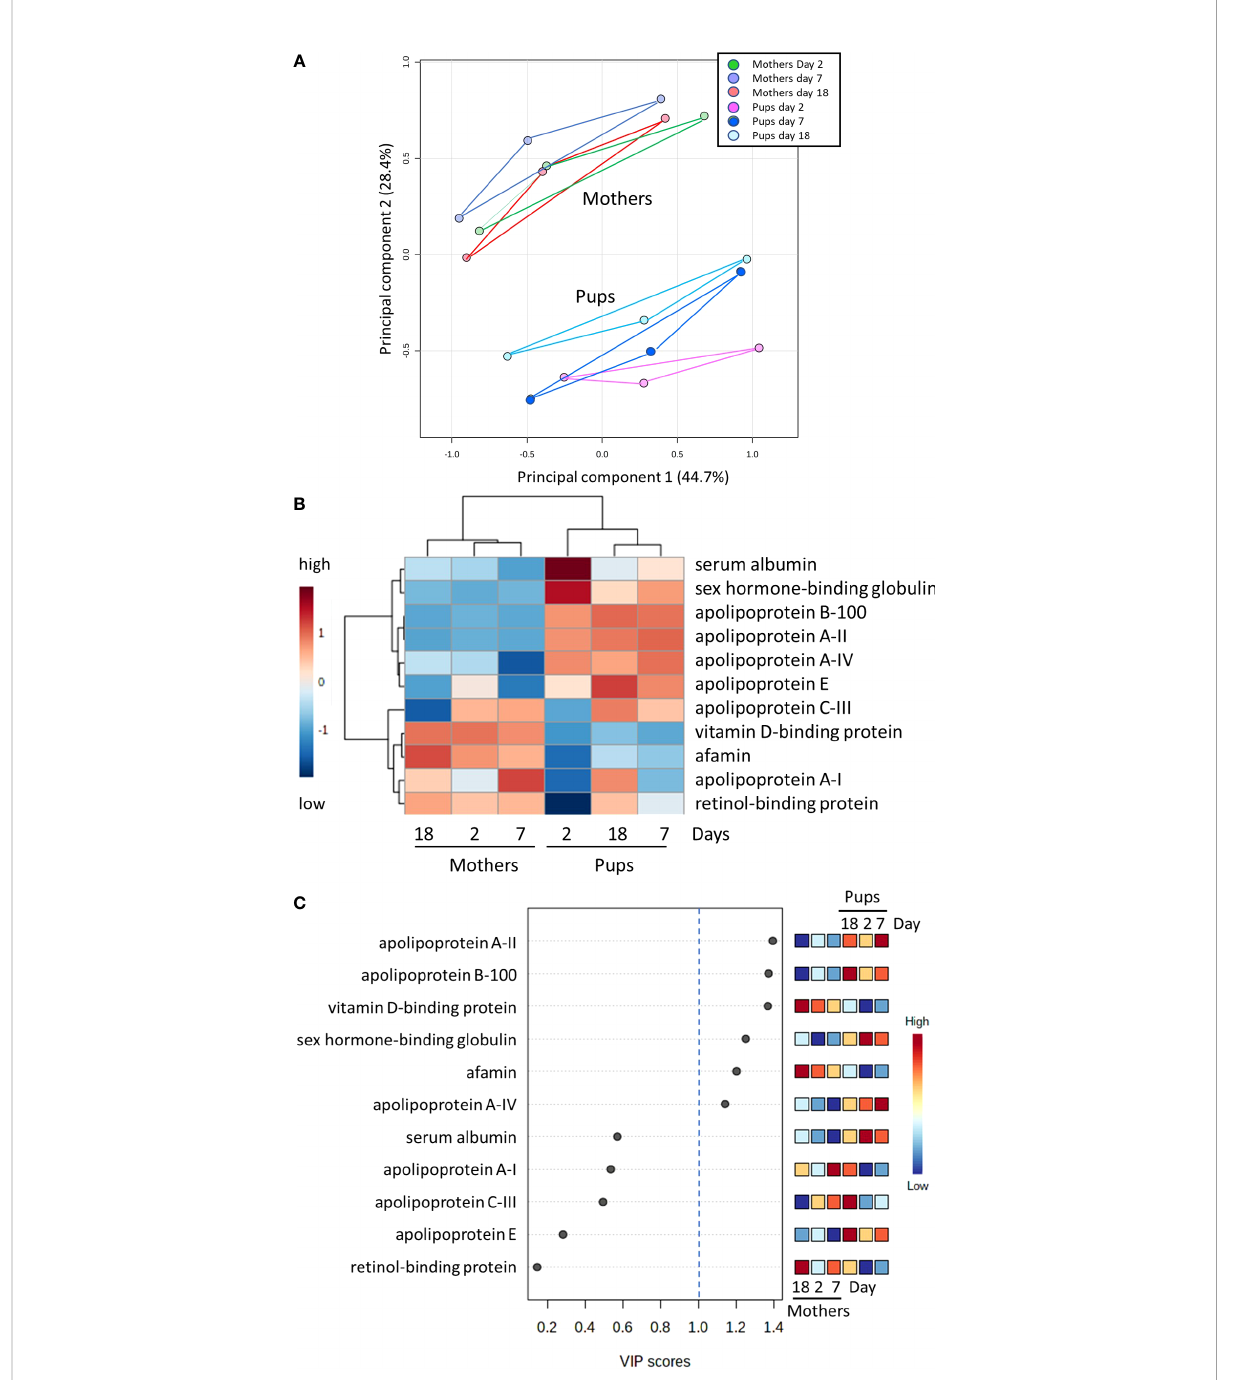
FIGURE 2 Contrasting pro fi les of serum lipid carrier proteins in mother and pup grey seals with time after birth. (A) Principal component analysls based on log transformed relative abundance data for the proteins listed in (B) . Values were obtained from TMT proteomics from three mother and pup pairs (pairs B, D and E) see Supplementary B) sampled on days 2, 7, and 18 after birth. (B) Heatmap with hierarchical clustering of the lipid carrier proteins. The heatmap was created with group averages (three pups on the given day after birth, three mothers on the given day). Note how the cluster dendrogram above the heatmap differentiates mothers ’ sera from pups on all days. The day order is as automatically determined in the analaysis in comparing the overall protein balance in the grouped samples. A similar heatmap from the same dataset but for individual mothers and pups is given in Supplementary Figure S1. (C) Variable importance projection analysis (VIP) of the data. Proteins that have scores greater than 1 (indicated by the dotted blue line) best segregate mother and pup